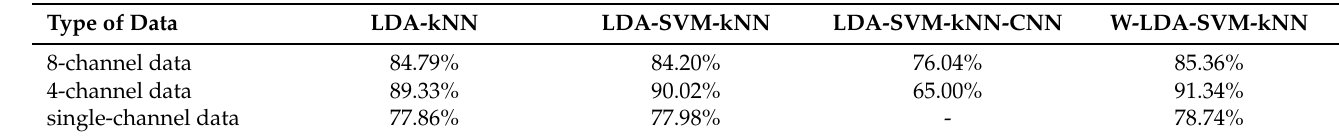
Table 6. Test results accuracy using ALS patients’ data with different